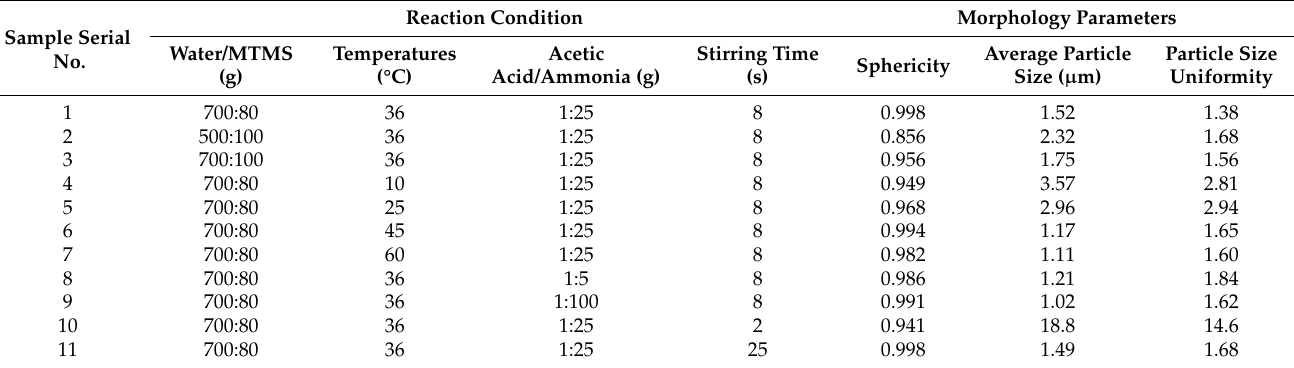
Table 1. Summary of as-prepared PMSQ microspheres via different reaction conditions. Sample Serial